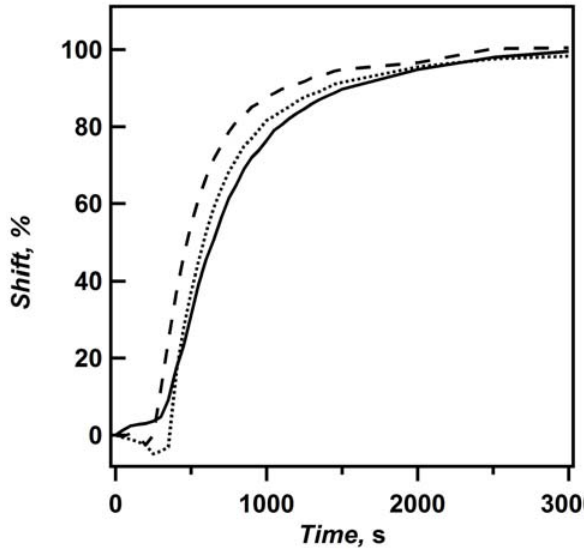
Figure 8. Plot of percent shift as a function of time for etalons with 25 nm overlayers and areas of (solid) 6.25 cm 2 , (···) ~2.5 cm 2 , and ( − − − ) ~0.9 cm 2 . Reprinted with permission from [14] Copyright (2011) American Chemical